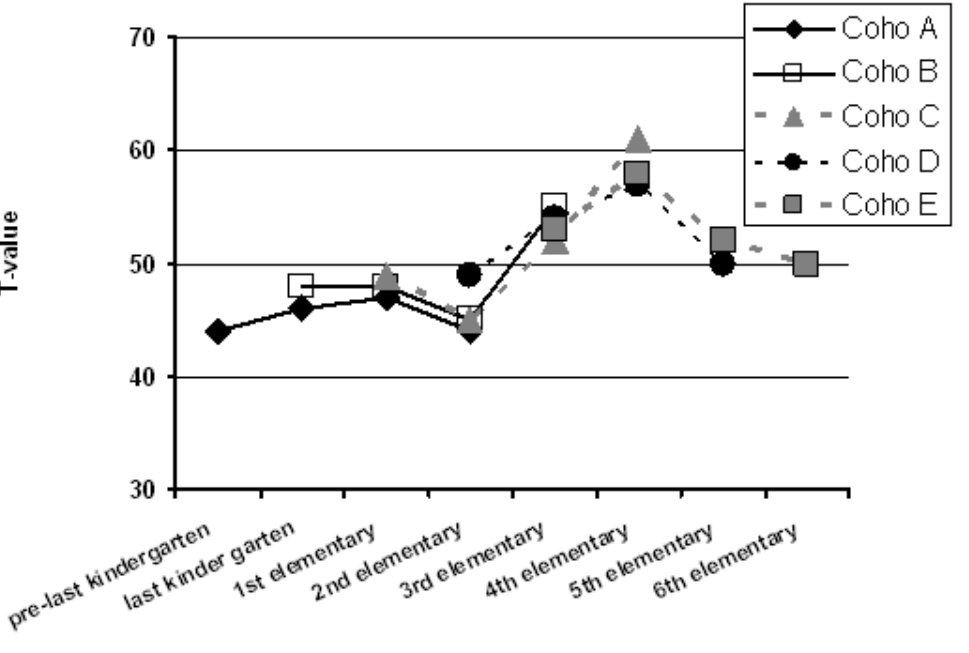
Figure 3. Cross-sequential results on ideational flexibility in the Luxembourg